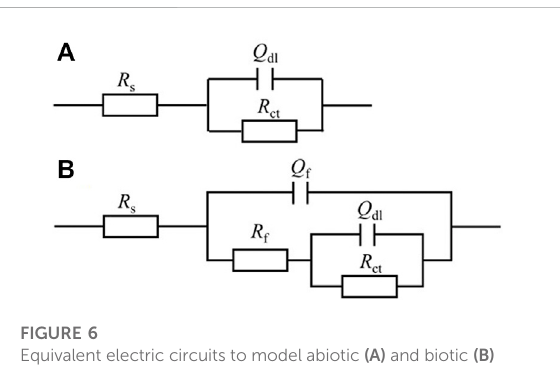
FIGURE 6 Equivalent electric circuits to model abiotic (A) and biotic (B) EIS spectra in Figure